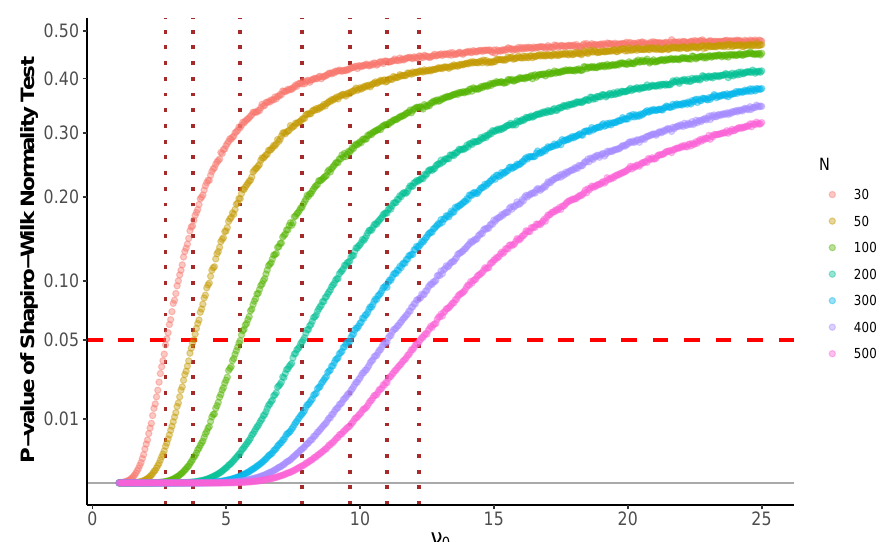
Figure 1. Median of the p -values of the Shapiro–Wilk test from 100,000 replicated observations ( x ) with different sample size N ∈ { 30,50,100, 200,300,400,500 } . The true x = ( x 1 , x 2 , · · · , x N ) ∼ t ν 0 data generating parameter ν 0 is selected from the effective support I e = ( 0,25 )